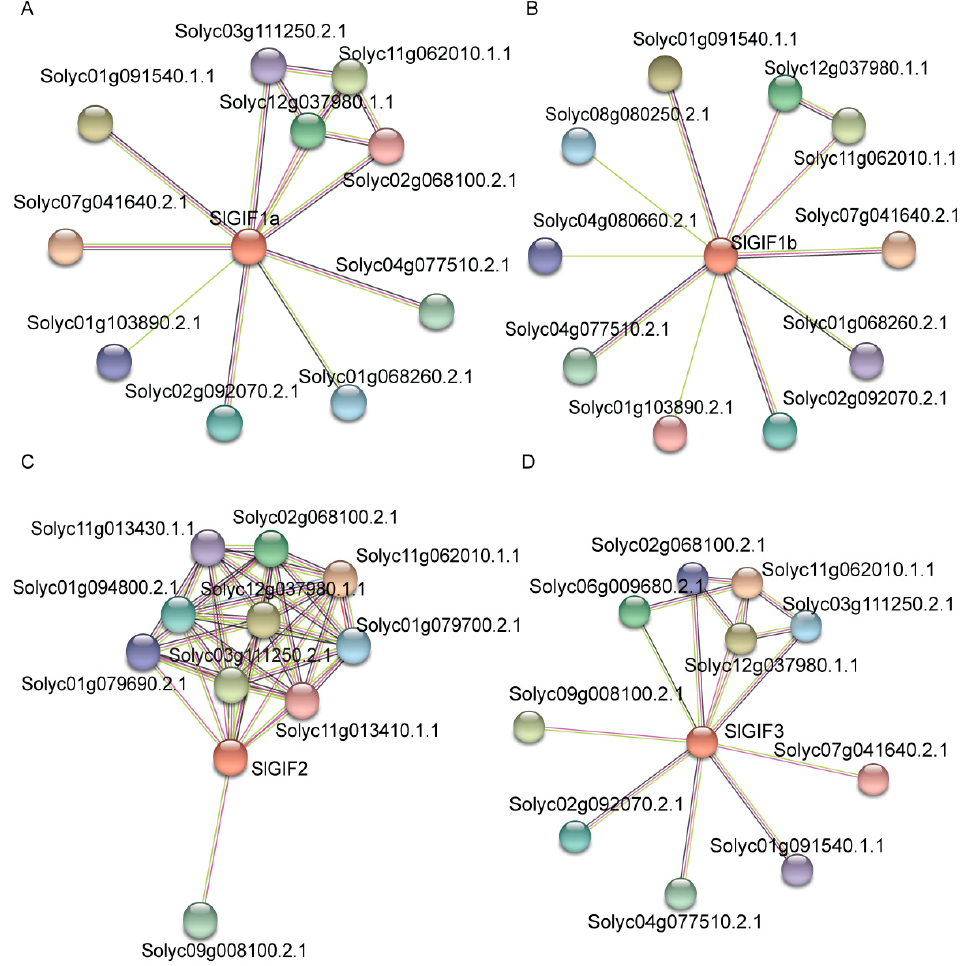
Figure 9. Predicted protein association networks analyses of SlGIF proteins: ( A ) SlGIF1a; ( B ) SlGIF1b; ( C ) SlGIF2; and ( D ) SlGIF3. The nodes represent the proteins, and the lines represent the protein–protein associations. Light blue and purple lines represent the known interactions from curated database or experimentally determined; green, red, and blue lines represent gene neighborhood, gene fusions, and gene co-occurrence, indicating the proteins are the predicted interactions; yellow, black, and light sky blue lines represent textiming, co-expression, and protein homology, respectively.